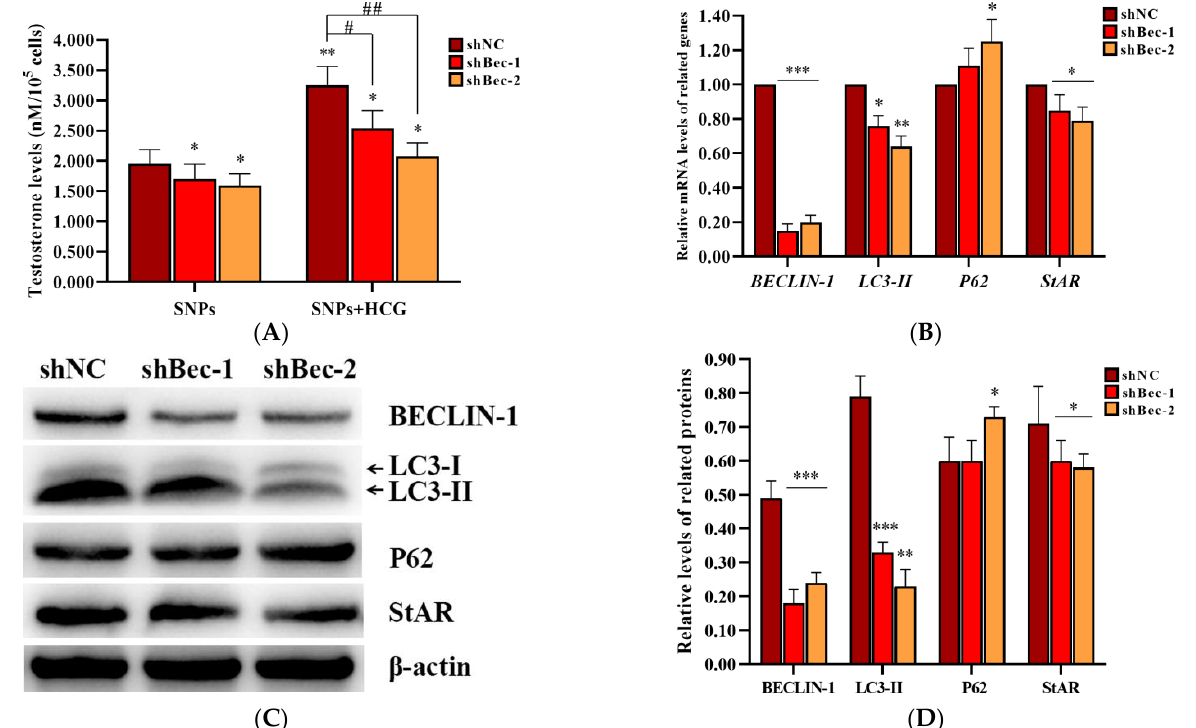
Figure 7. Effect of BECLIN-1 knockdown on testosterone secretion in PLCs. ( A ) Detection of the concentration of testosterone via ELISA analysis in the PLC culture supernatant. ( B ) Measurement of BECLIN-1 , LC3-II , P62 , and StAR mRNA levels in PLCs via qRCR analysis. ( C ) Determination of the expression of BECLIN-1, LC3-II, P62, and StAR protein levels in PLCs via Western blot analysis. PLCs were transduced with BECLIN-1 knockdown lentiviruses and exposed to 100 µg/mL SNPs in the absence or presence of 1 IU/mL HCG for 12 h. ( D ) Quantification of the band intensity in C is presented as the relative ratio of target proteins to β -actin. Data are presented as the mean ± SEM of three independent experiments. * Statistically different from the shNC + SNP group (* p < 0.05, ** p < 0.01, and *** p < 0.001); # statistically different from the shNC + SNP + HCG group ( # p < 0.05 and ## p < 0.01).